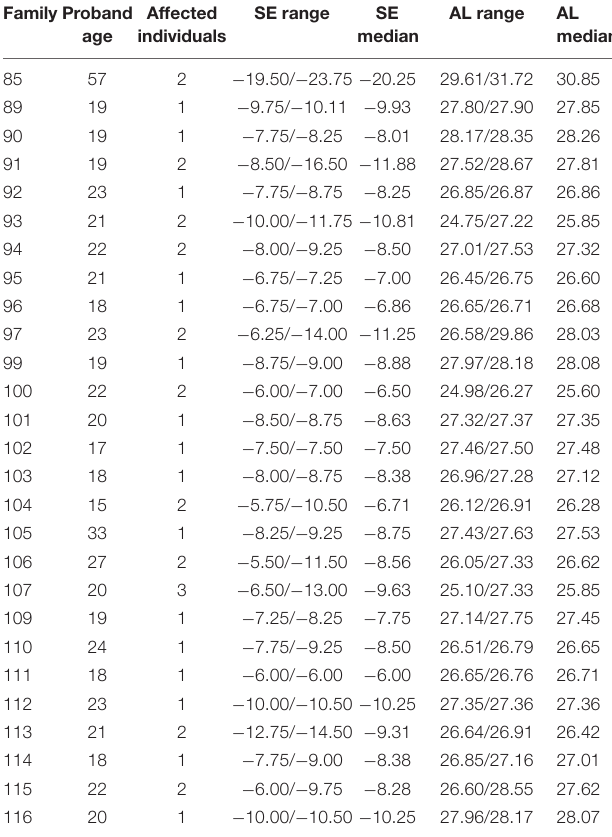
TABLE 1 | Clinical data from 27 families with high myopia. Family Proband